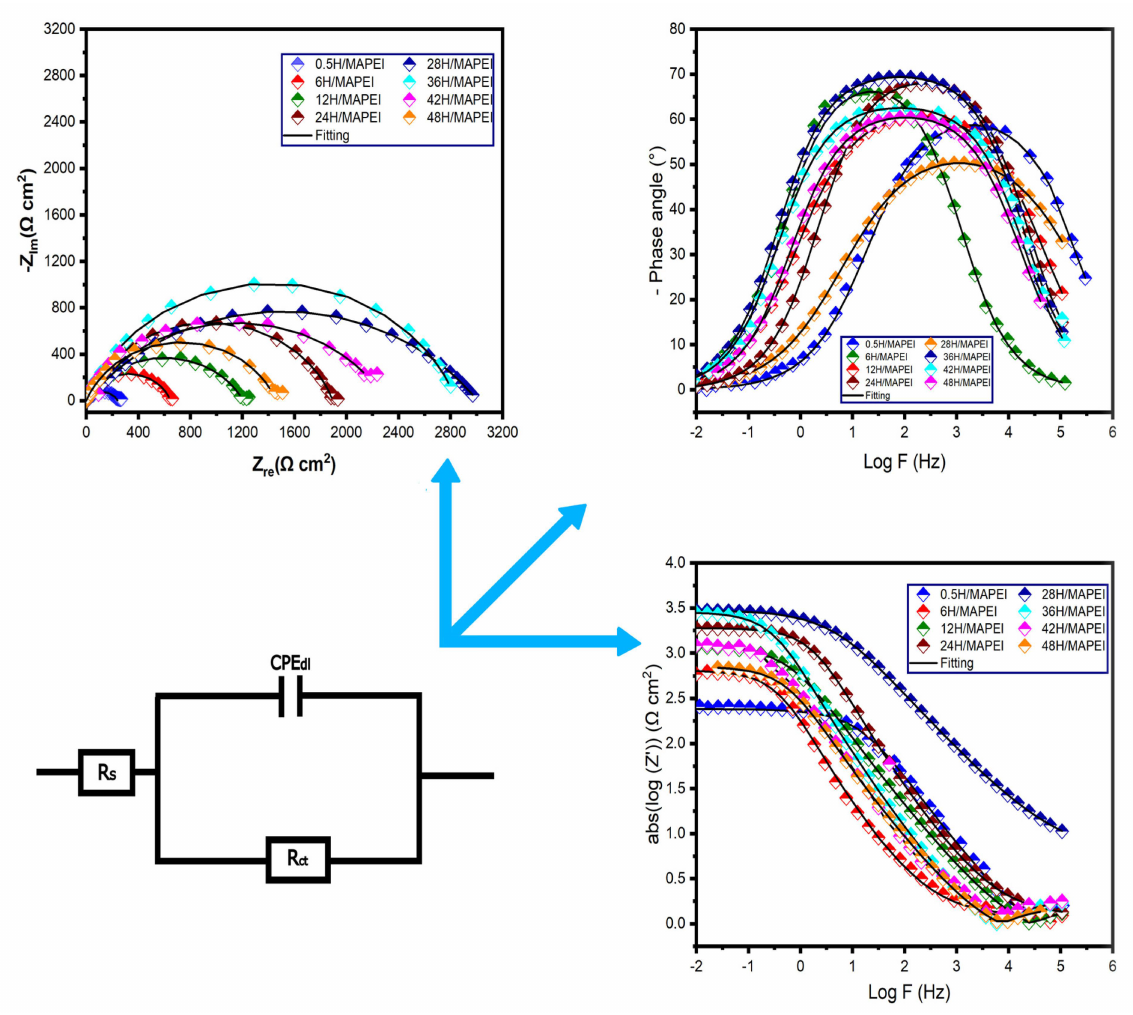
Figure 4. EIS and Bode diagrams of N80 steel substrate immersed in 15% HCl solution with 5 × 10 − 3 M of MAPEI at 303 K at various immersion times.